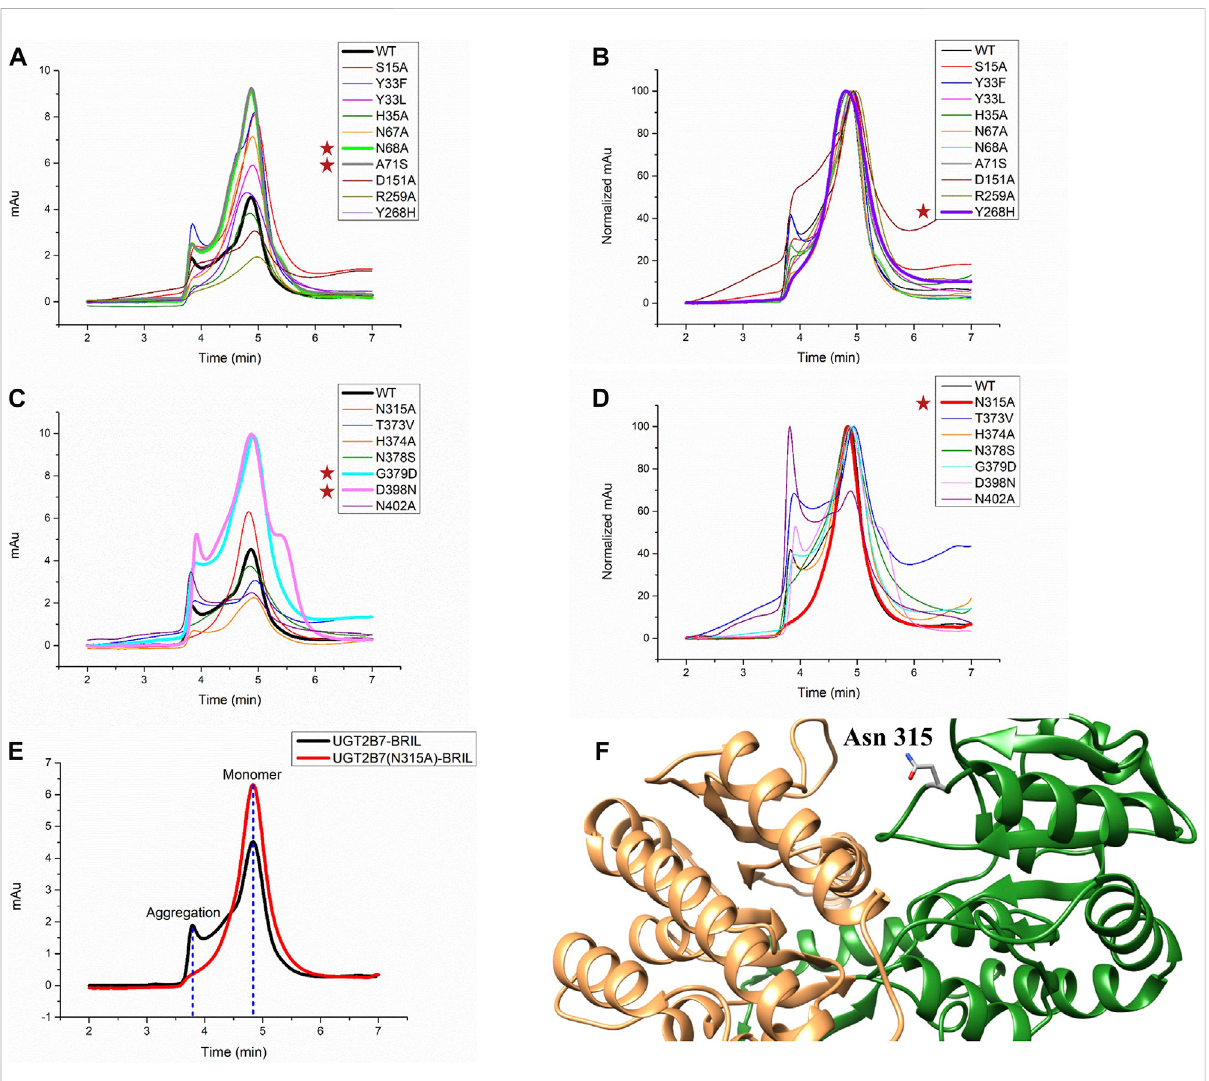
FIGURE 3 Screening for mutations of UGT2B7-BRIL. (A) Diagram of size exclusion chromatography of different mutations at the UGT2B7-BRIL N-terminus. (B) Aligned the curves in A shows protein homogeneity. (C) Diagram of SEC of different mutations at the UGT2B7-BRIL C-terminus. (D) Alignedthecurvesin (C)(E) ComparisonoftheSECcurveswiththeintroductionoftheN315Amutation.Flowrate:0.5 ml/min. (F) Predictedstructure of UGT2B7 using AlphaFold2 Protein StructureDatabase. The N-terminus and C-terminus are colored inorange and green and highlightedthe side chain of